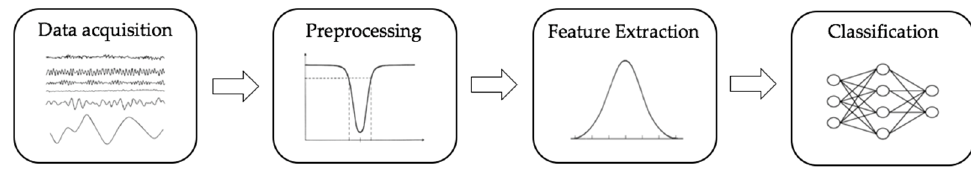
Figure 1. Overall signal analysis divided in signal acquisition, preprocessing, feature extraction, and classification.